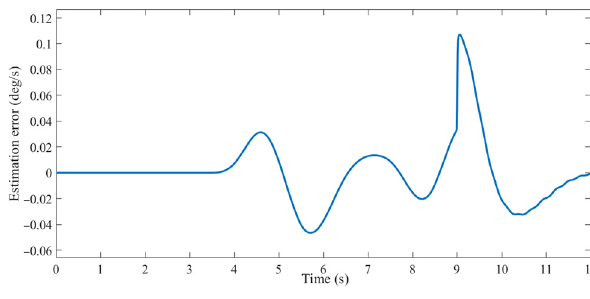
Figure 15 Fault estimation error curve of the yaw rate sensor by estimation method in this paper